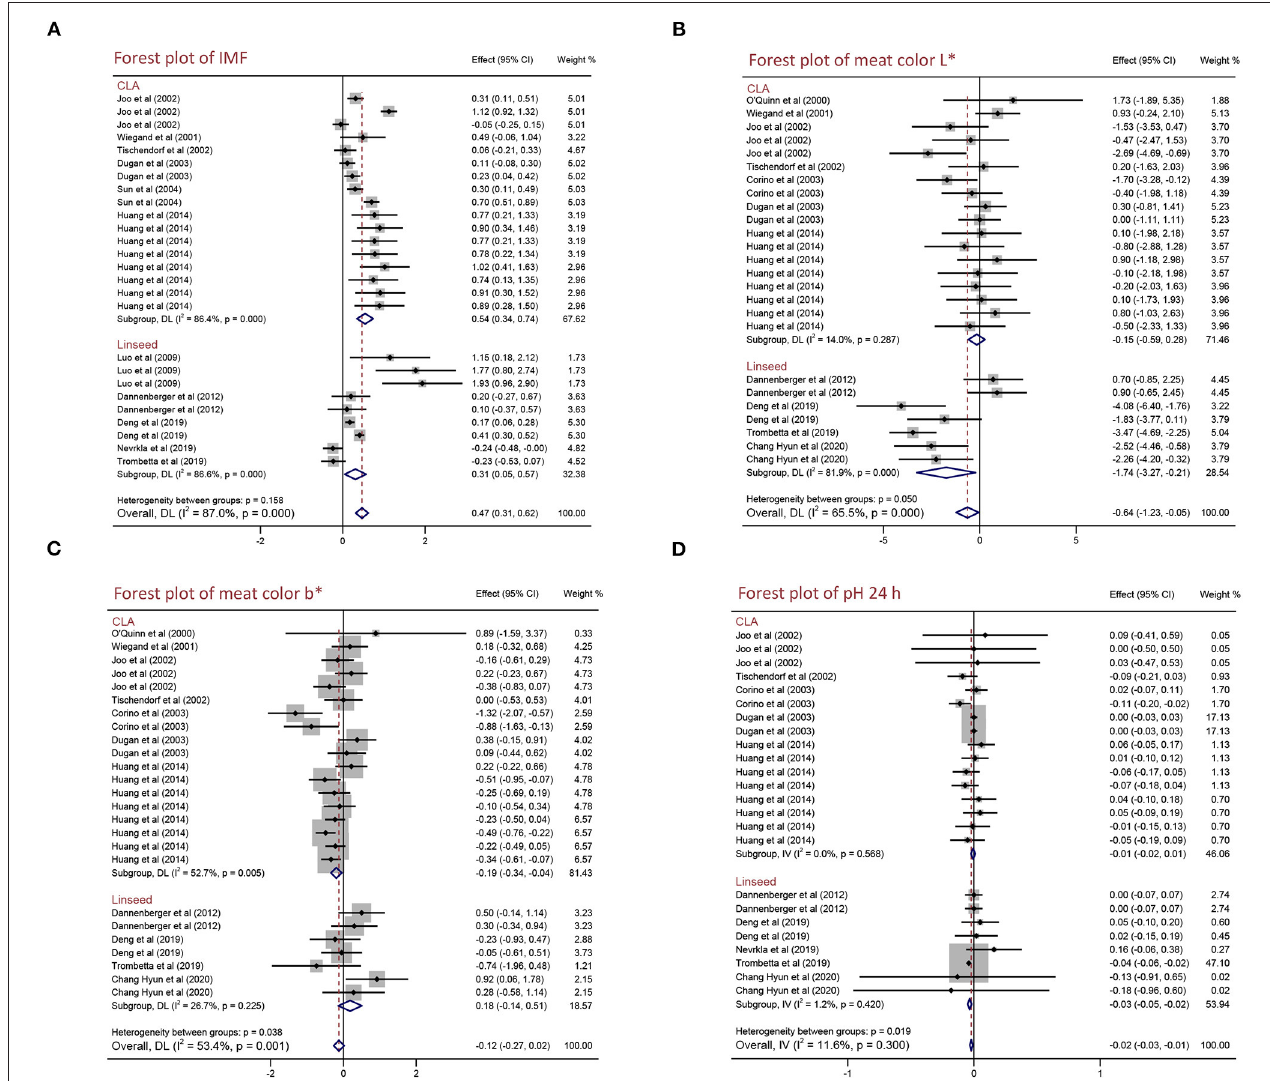
FIGURE 2 | Forest plot of the effects of CLA or linseed on the meat quality of pigs. (A) IMF, (B) meat color L*, (C) meat color b*, and (D) pH 24h. WMD, weighted mean difference; CLA, conjugated linoleic acid. The small solid diamond represents the point estimate for each individual trial, and the horizontal line extending from each solid diamond represents the upper and lower limits of the 95% CI. The size of the shaded square indicates the relative weight of the trial in the meta-analysis. The hollow diamond represents the WMD and 95% CI of the trials, no intersection of the diamond and the solid black line in the middle indicates a significant difference ( p < 0.05), vice